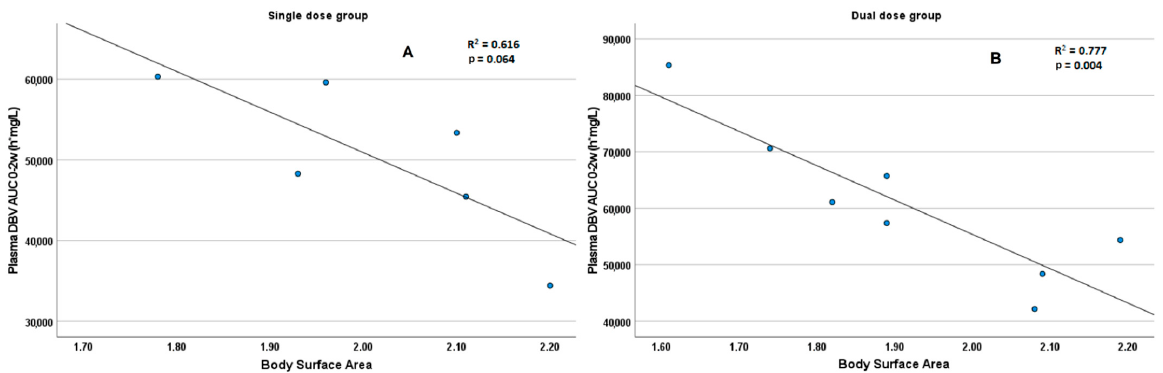
Figure 3. Scatter plots summarizing the distribution of DBV overall AUC 0-2w values in single dose group ( A panel) and in the dual dose group ( B panel), based on the BSA (m 2 ). Borderline significance was observed for the single dose group, while the correlation was highly significant in the dual dose group. Table 4. Summary of the PK/PD parameters calculated for each patient. The PK/PD calculations corrected by protein The observed PK parameters were compared with the PD susceptibility breakpoints binding were performed using MIC/0.07 as a correction factor, simulating human plasma protein binding. The first dose indicated by EUCAST and are summarized in Table 4. AUC 0-1w was considered for the dual dose group. Total AUC 0-2w for the dual dose group was calculated as the sum of the first dose AUC 0-1w and the second dose AUC 0-1w .